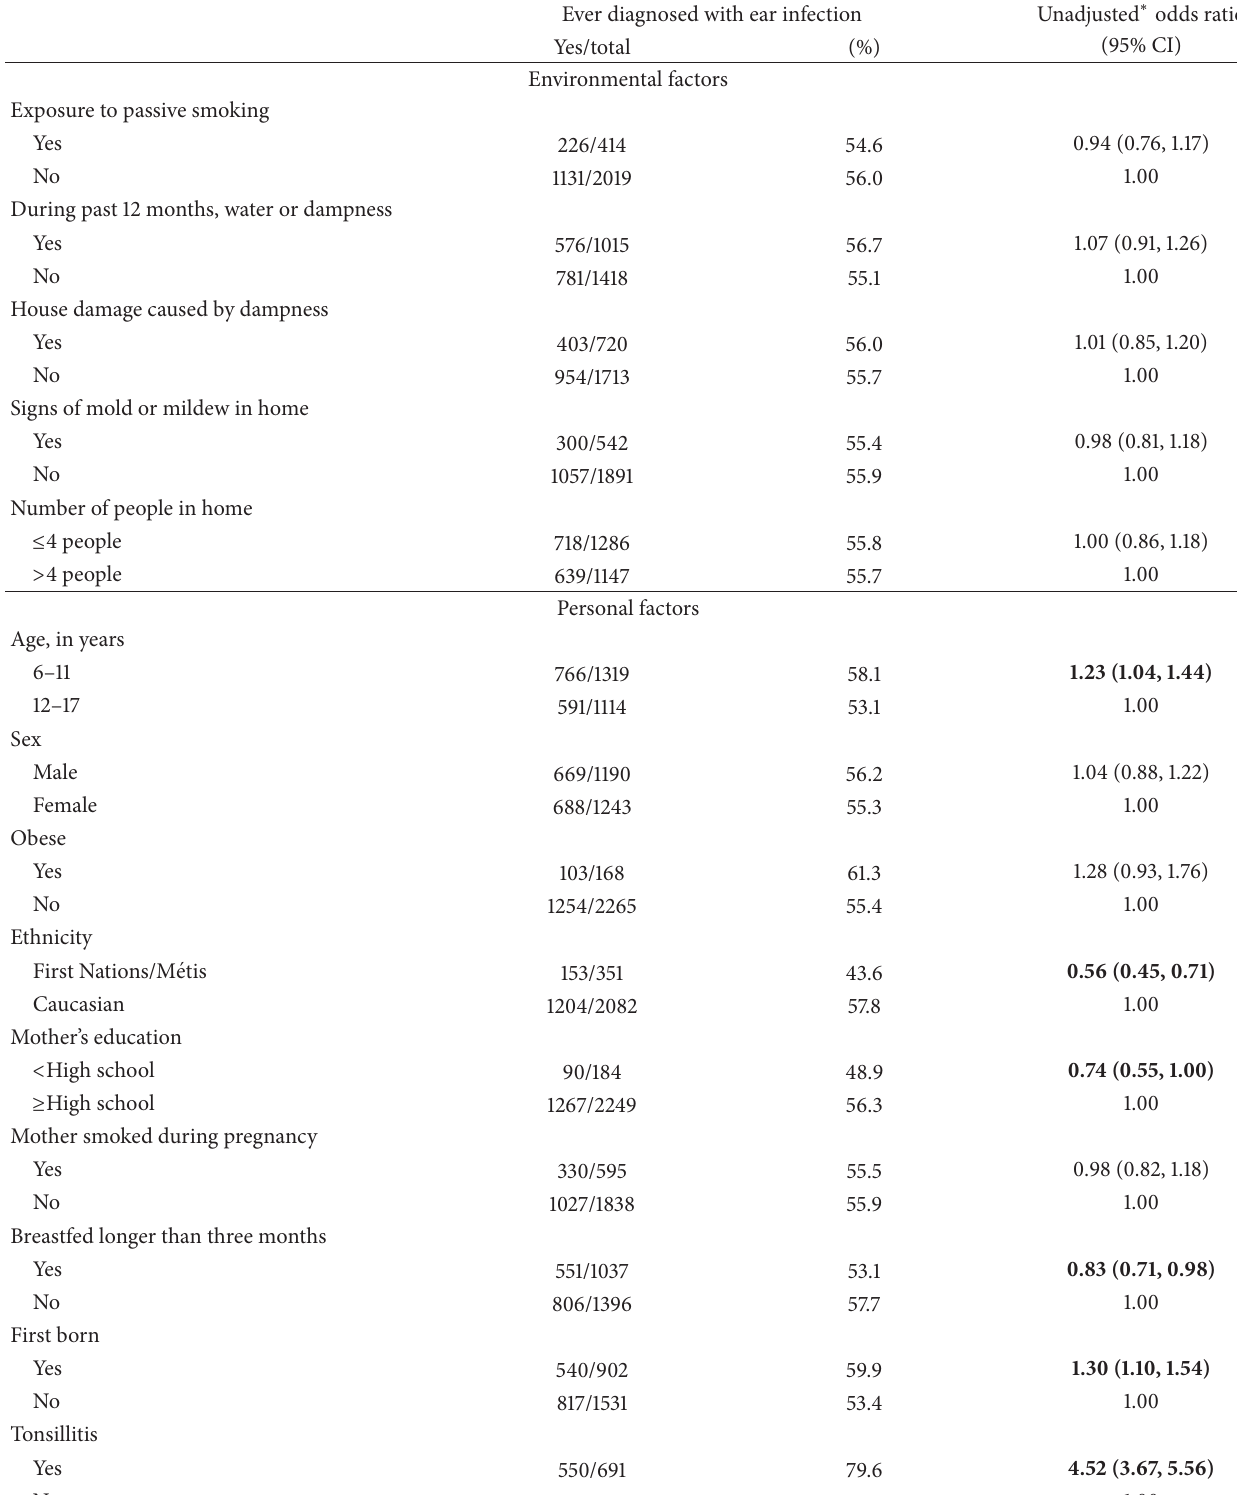
Table 2: Bivariable logistic regression analysis of the association of physician diagnosed ear infection on personal and environmental factors ( 𝑛 = 2433